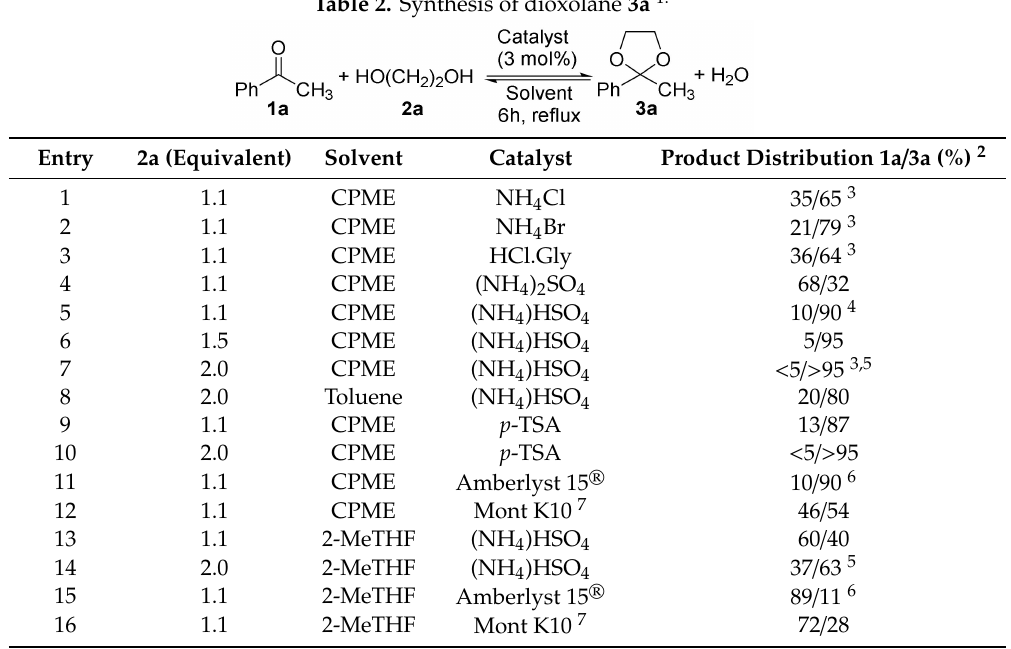
Table 2. Synthesis of dioxolane 3a